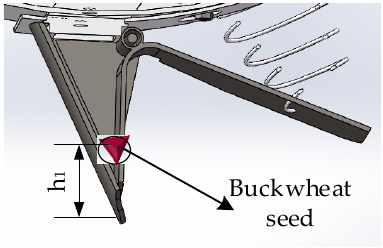
Figure 5. Buckwheat seed location diagram.